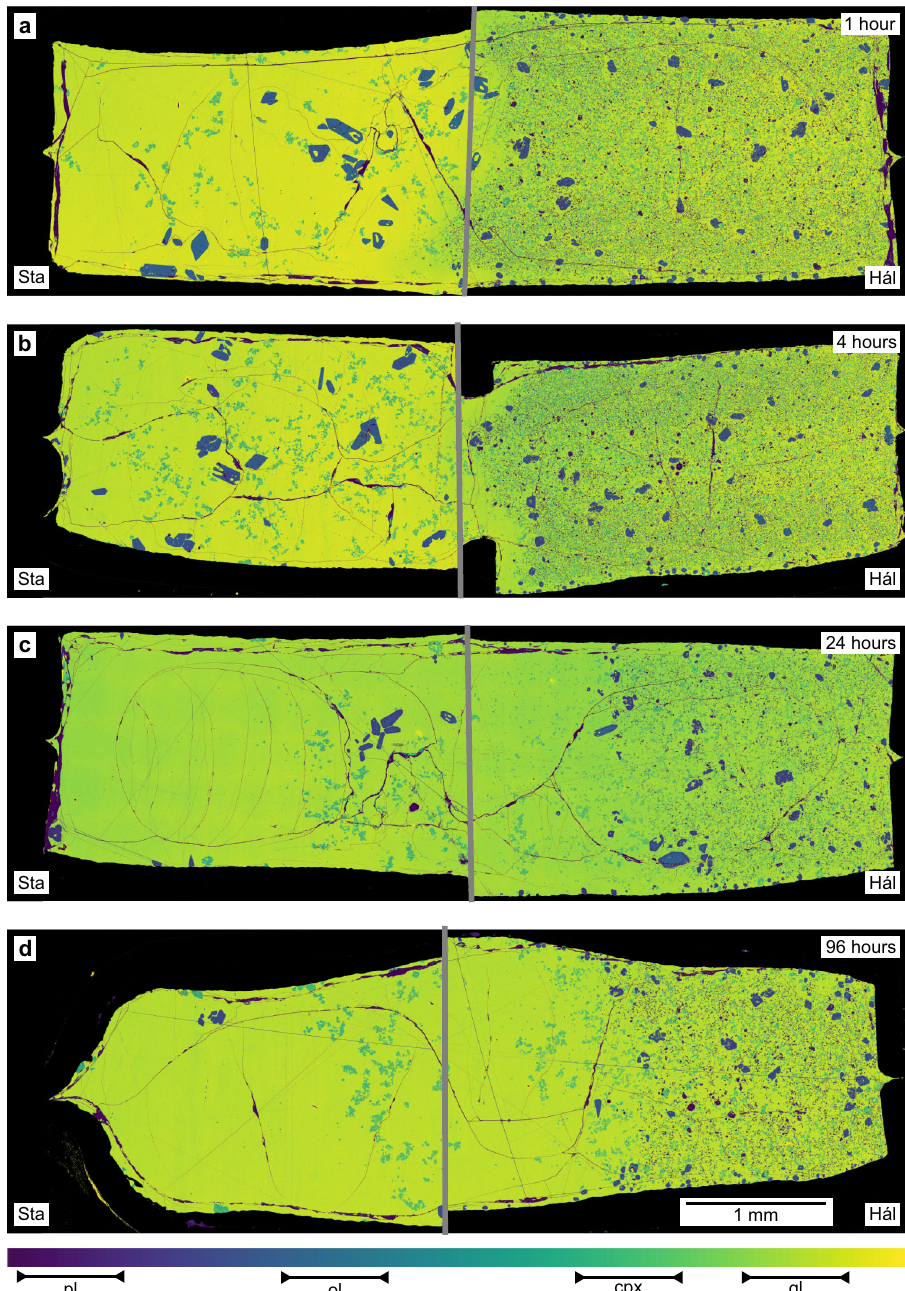
Fig. 3 False-colour backscattered electron (BSE) maps of the products of magma – magma reaction experiments. Magma – magma reaction experiments were performed by juxtaposing quenched magma cylinders from synthesis experiments on both Háleyjabunga (Hál) and Stapafell (Sta) lava analogues within new capsules. These new capsules were then subjected to exactly the same conditions used during synthesis experiments (300 MPa and 1190 °C). a – d BSE maps show the products of experiments run for 1 h ( a ), 4 h ( b ), 24 h ( c ) and 96 h ( d ). Magma cylinders synthesised from the incompatible element-depleted Háleyjabunga lava analogue are on the right, and magma cylinders synthesised from the incompatible element-enriched Stapafell lava analogue are on the left. Grey lines show the positions of original interfaces between juxtaposed magma cylinders. Plagioclase (pl) is the lowest BSE intensity phase (purple, only towards the right), followed, in order of increasing intensity, by olivine (ol, blue), clinopyroxene (cpx, blue-green) and glass (gl, green to yellow). Occasional bright fl ecks are small fragments of capsule material detached during sample preparation and are of no geological signi fi Al and Ti) and oxygen 34 . In contrast, estimated diffusivities of and η is the average viscosity of the two end-member melts (12.5 Pa.s), calculated here with the model of Giordano et al. 50 ) 51 ; lower- fi eld strength Na 2 O and K 2 O are higher, re fl ecting variable Eyring diffusivities are typically good at describing the behaviour degrees of decoupling from network-forming cations (Fig. 7e, of relatively high- fi eld strength network-forming cations (i.e. Si, f) 52,53 . Finally, we note that melt H 2 O contents were not reported